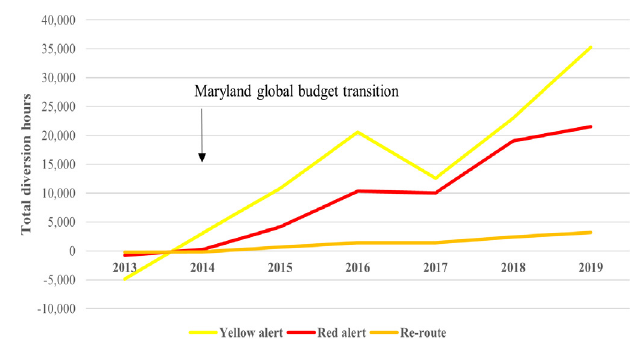
Figure 2. Cumulative absolute change in ambulance diversion time by diversion type in Maryland since 2013. Note. Diversion hours were yellow alert =17,377, red alert = 7648, and re-route = 1396 in